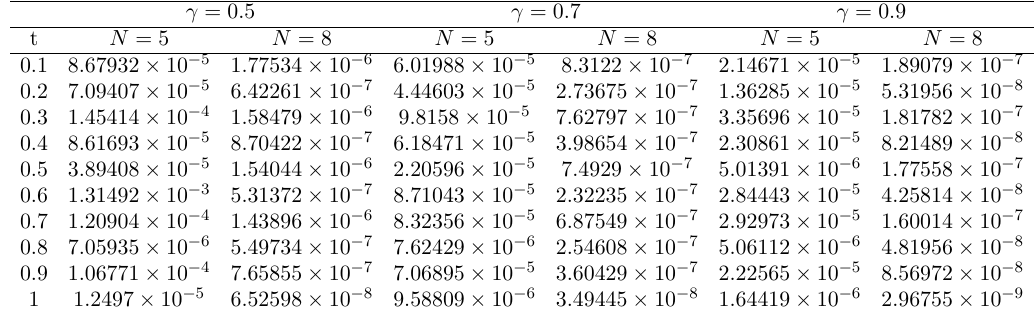
Table 3. Absolute errors of J at N = 5 for different values of γ in Example 2.